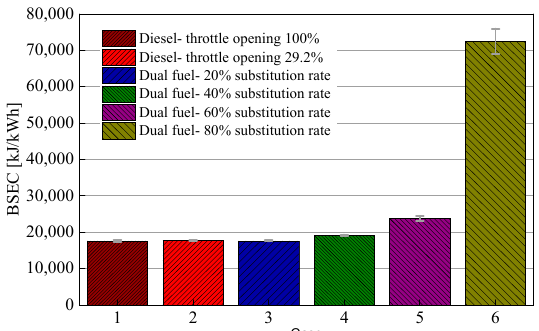
Figure 6. BSEC comparison with different substitution rates at 1600 rpm, 27.1 N·m.